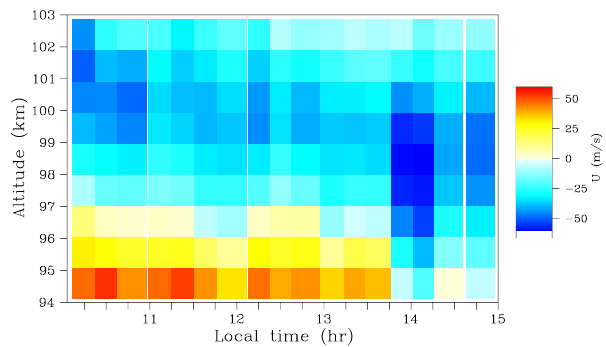
Fig. 7. Zonal neutral wind speeds in the electrojet region inferred from the Doppler shifts of oblique VHF type 2 radar echoes. Note that the height resolution of this technique is inherently